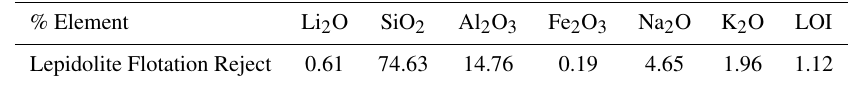
Table 1. Major elements analysis of the lepidolite flotation reject.